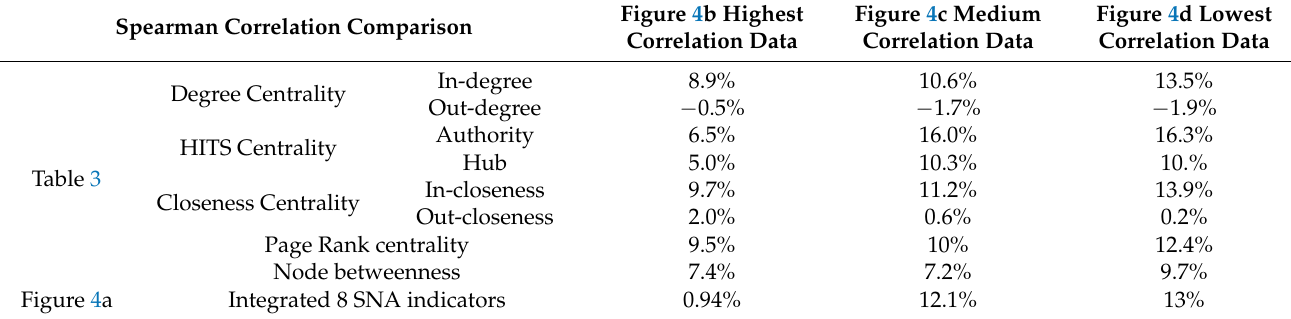
Integrated 8 SNA indicators